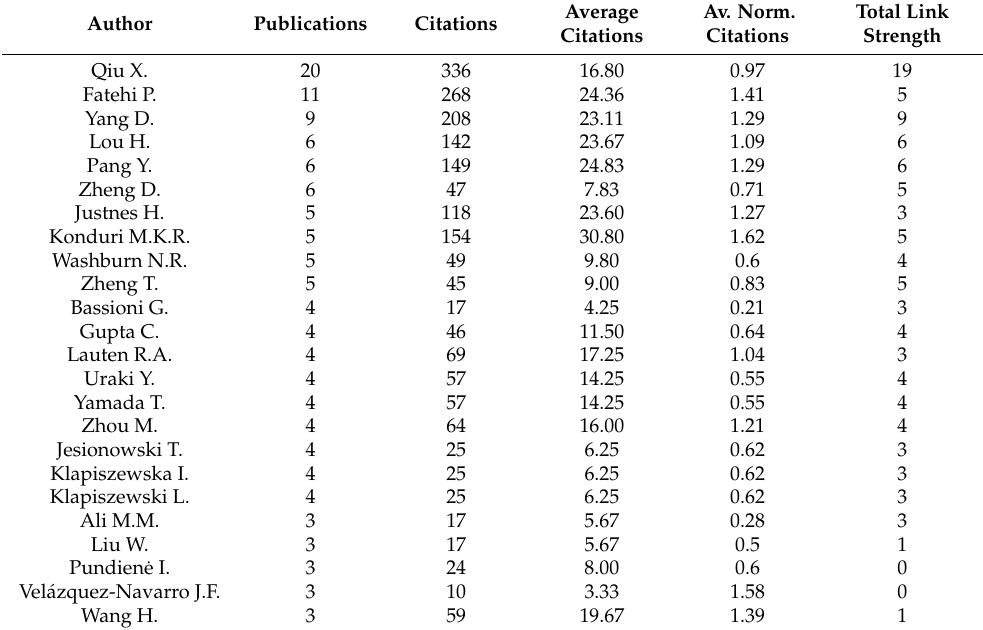
Table 3. Statistical analysis of collaborative scholars in the LBAs